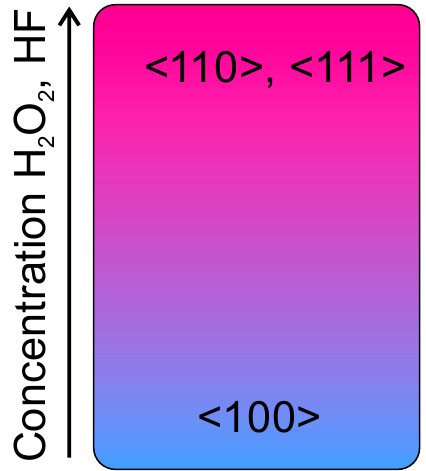
Figure 2. Schematic of preferred etching direction as a function of H 2 O 2 and HF concentration. The Si back bonds are preferentially removed along the <100> directions in conditions of both low H 2 O 2 and HF concentrations.